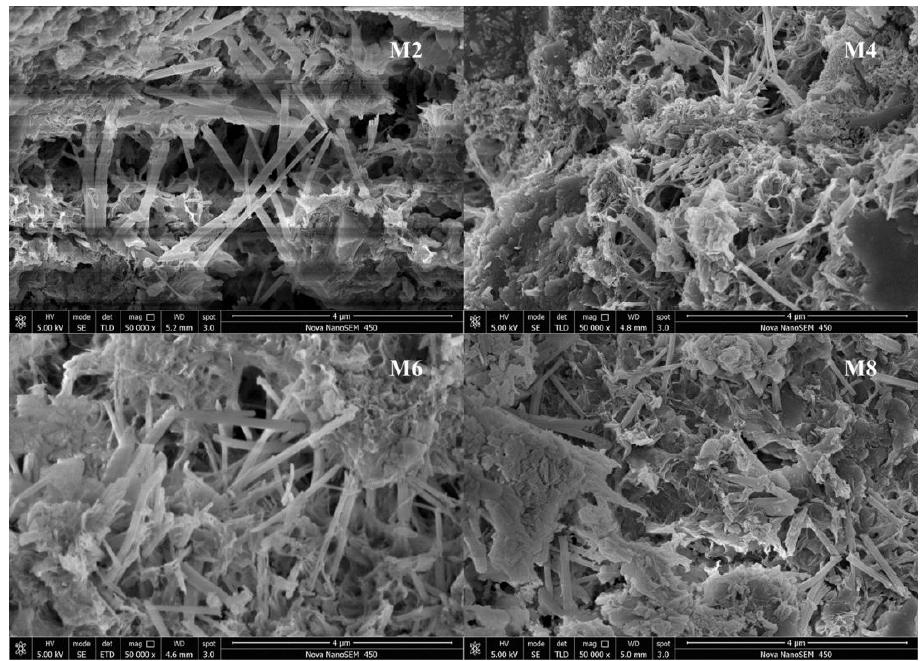
Figure 6. SEM images of the SAR specimens at 8 days.